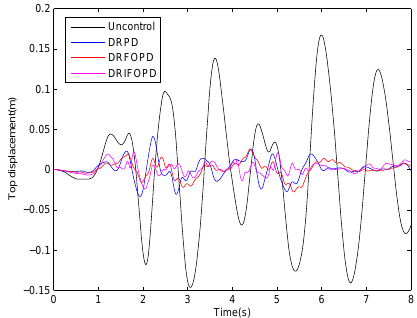
Figure 8. Top displacement curve under decentralized control.